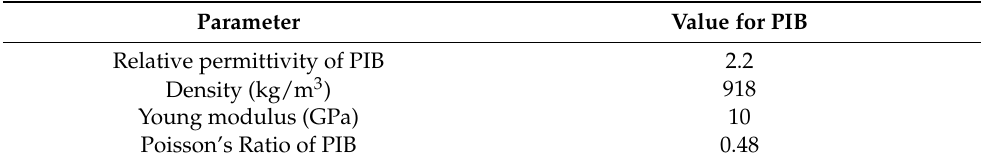
Table 1. Parameters of PIB used for simulation. Parameter Value for